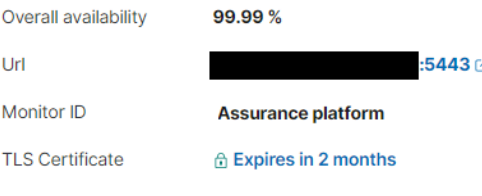
Figure 10. CYRA’s availability.